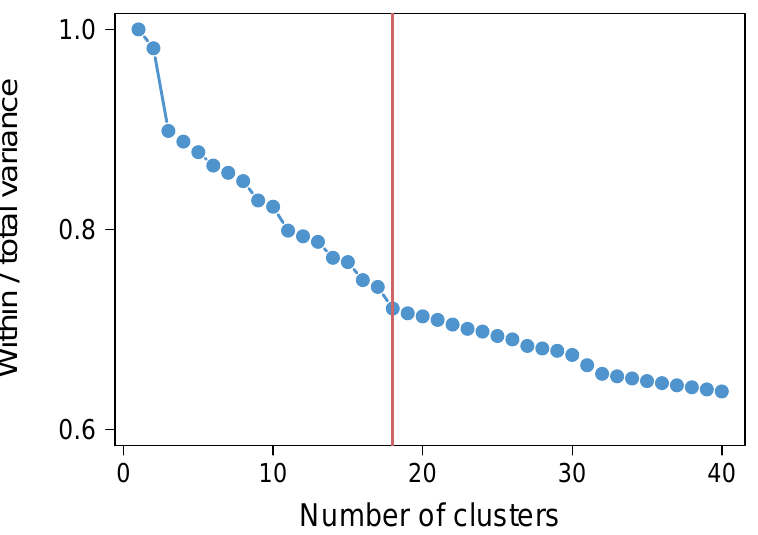
Figure A5. Ratio between the within-group variance and the total variance as a function of the number of clusters. The red line represents the selected number of clusters.